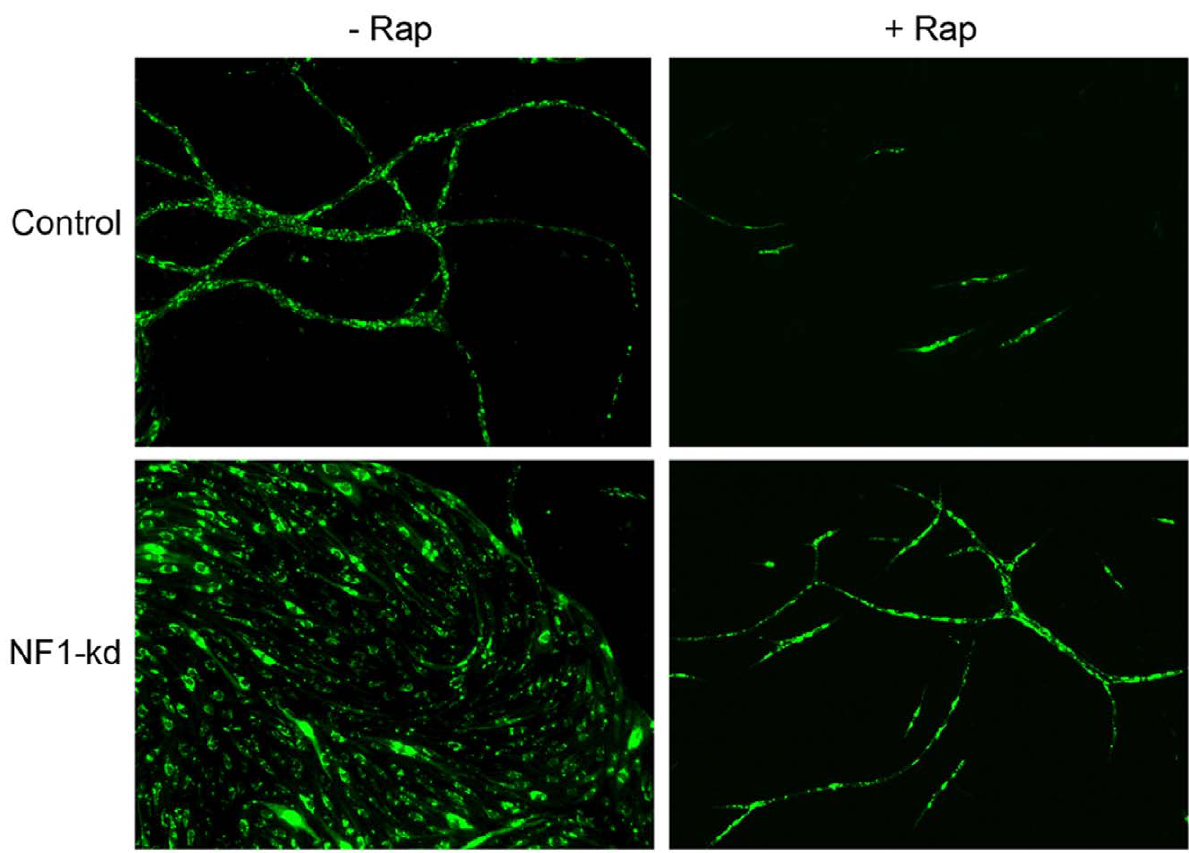
Figure 7. Abnormal vascular morphogenesis is normalized by Rapamycin. Endothelial cells infected with pSIREN expressing either non- targeting (control) or shRNA directed against NF1 (NF1-kd) were plated in co-culture with primary fibroblasts. Co-cultures were incubated in the presence of vehicle (DMSO) or Rapamycin (0.1 ng/ml) from the time of plating. Vascular structures are shown at day 14, visualized by expression of GFP in the endothelial cells by the pSIREN